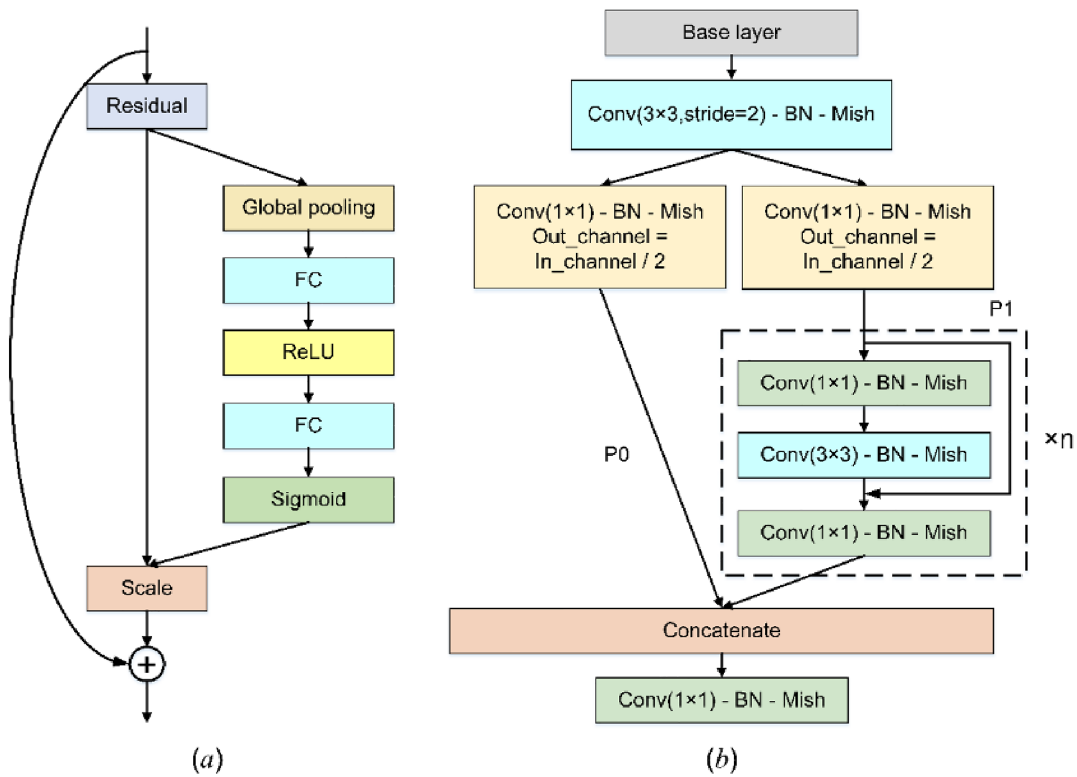
Figure 4. The structure of SE and CSPNet module. ( a ) SE module. ( b ) CSPNet